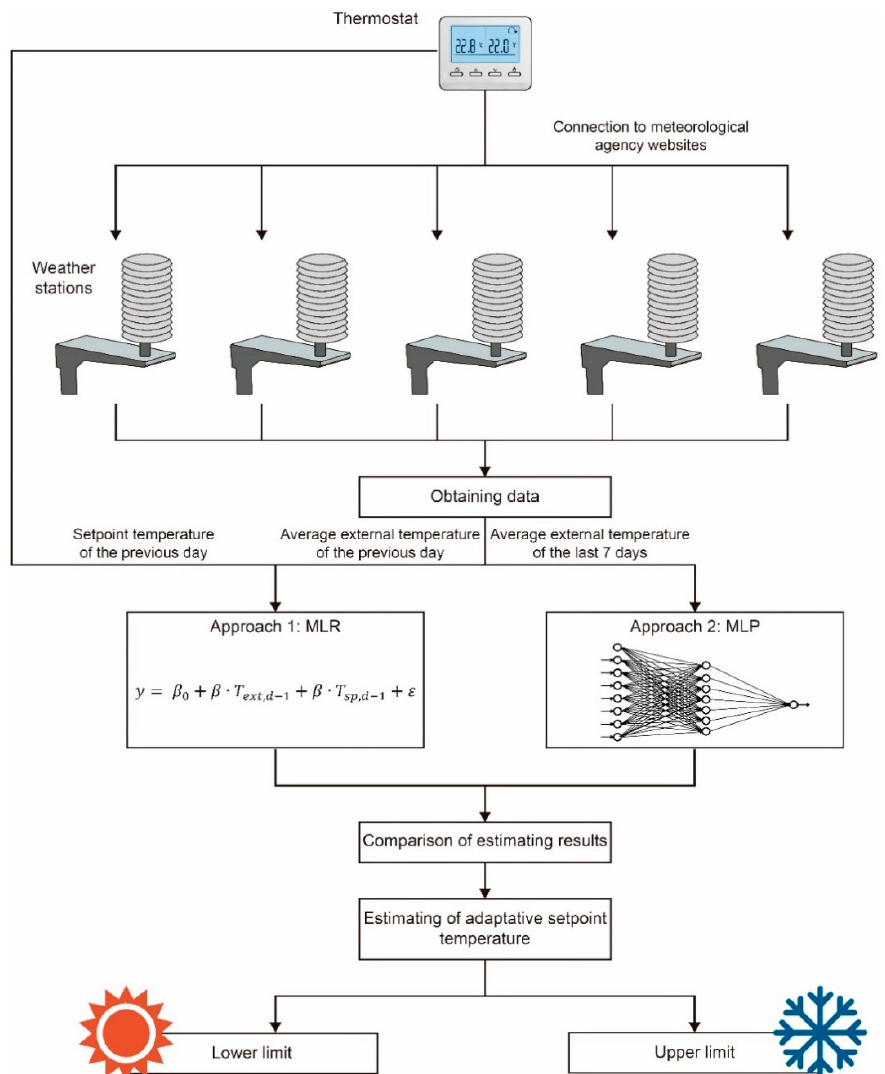
Figure 13. Estimation methodology of adaptive setpoint temperatures. Failures in the external temperature probe or temporary installation are considered.